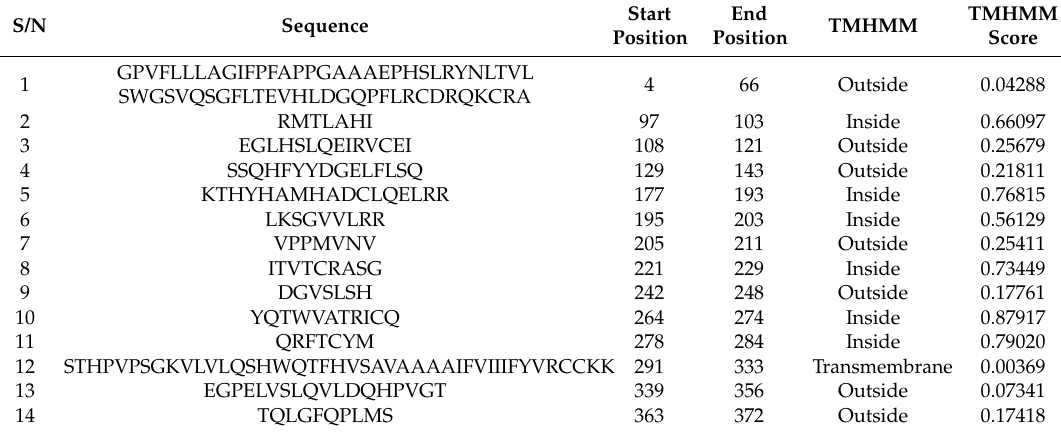
Table 1. Predicted antigenic epitopes within the MIC-A protein. A total of 14 epitopes are predicted, with six of those found within the transmembrane topology depicting potential antigenic peptides. More so, seven of the predicted epitopes are located outside the transmembrane topology and another one is found on the transmembrane itself; these are non-antigenic in